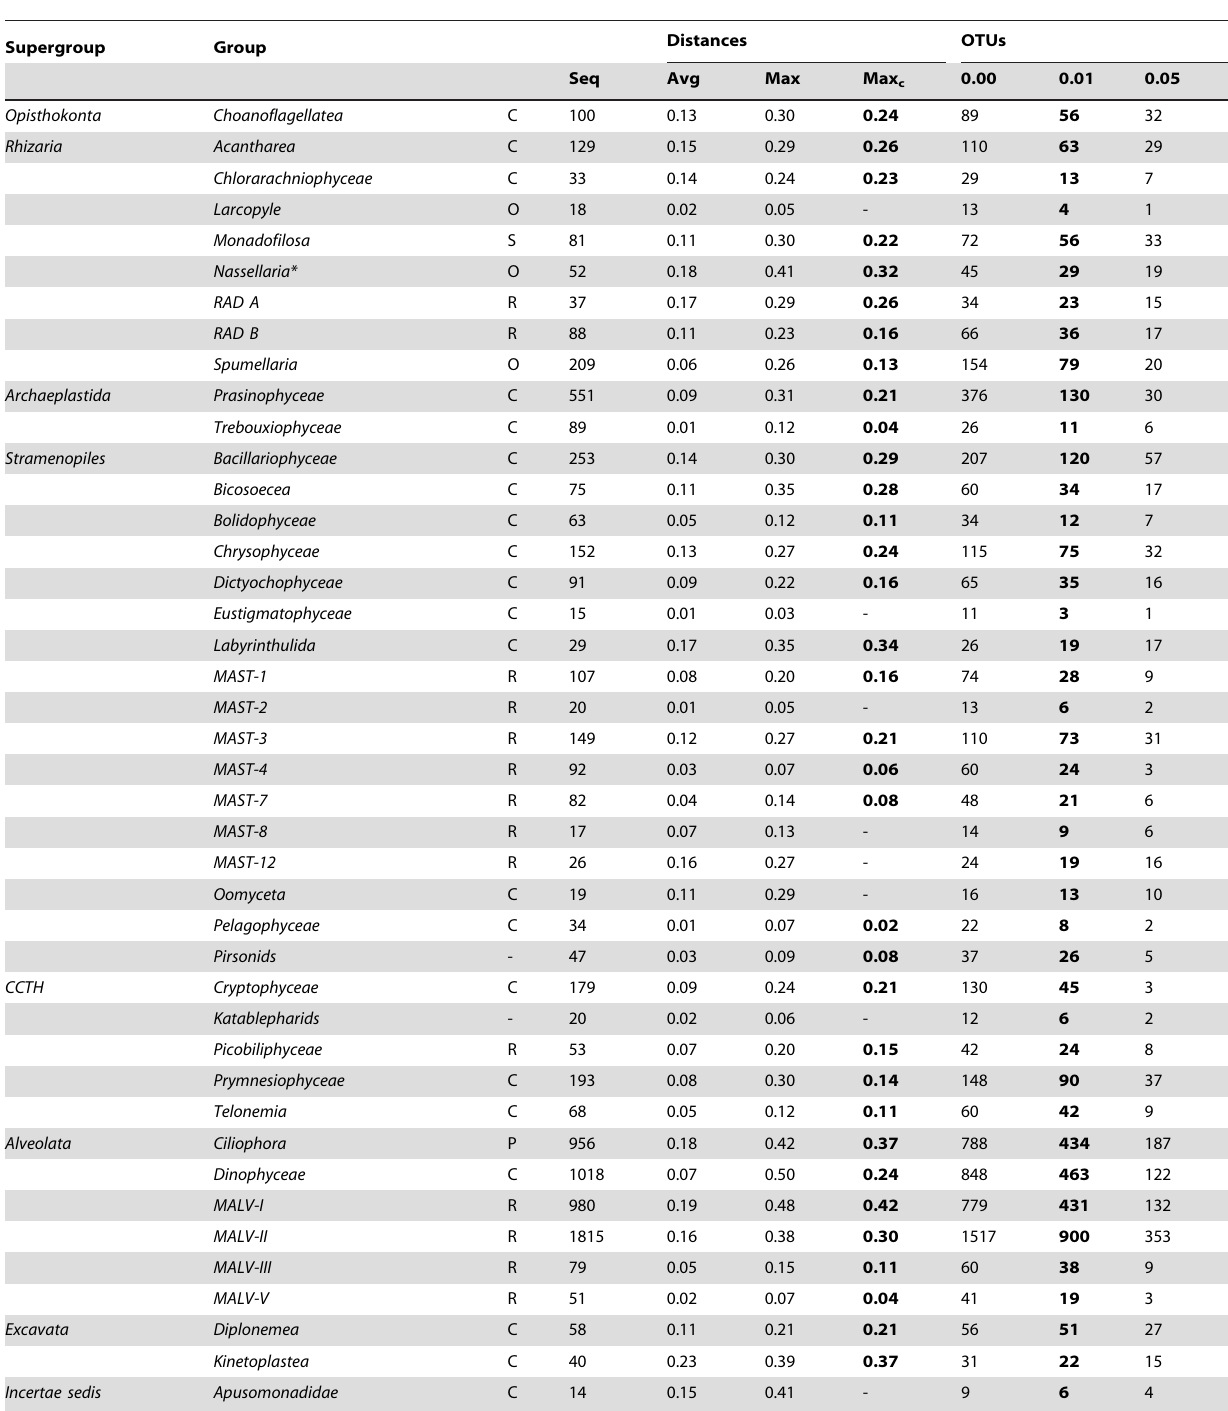
Table 1. Classification of environmental 18S rDNA sequences in 42 taxonomic major groups.